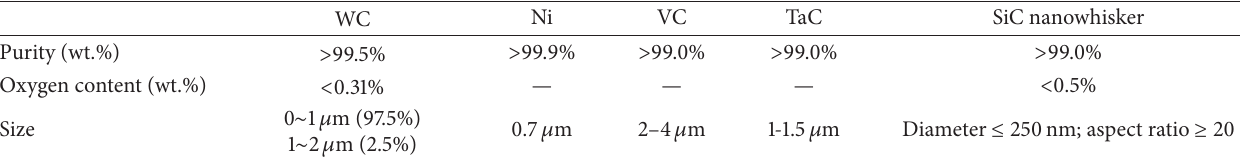
Table 1: Specifications of the raw materials applied in this work. WC Ni VC TaC SiC nanowhisker Purity (wt.%)